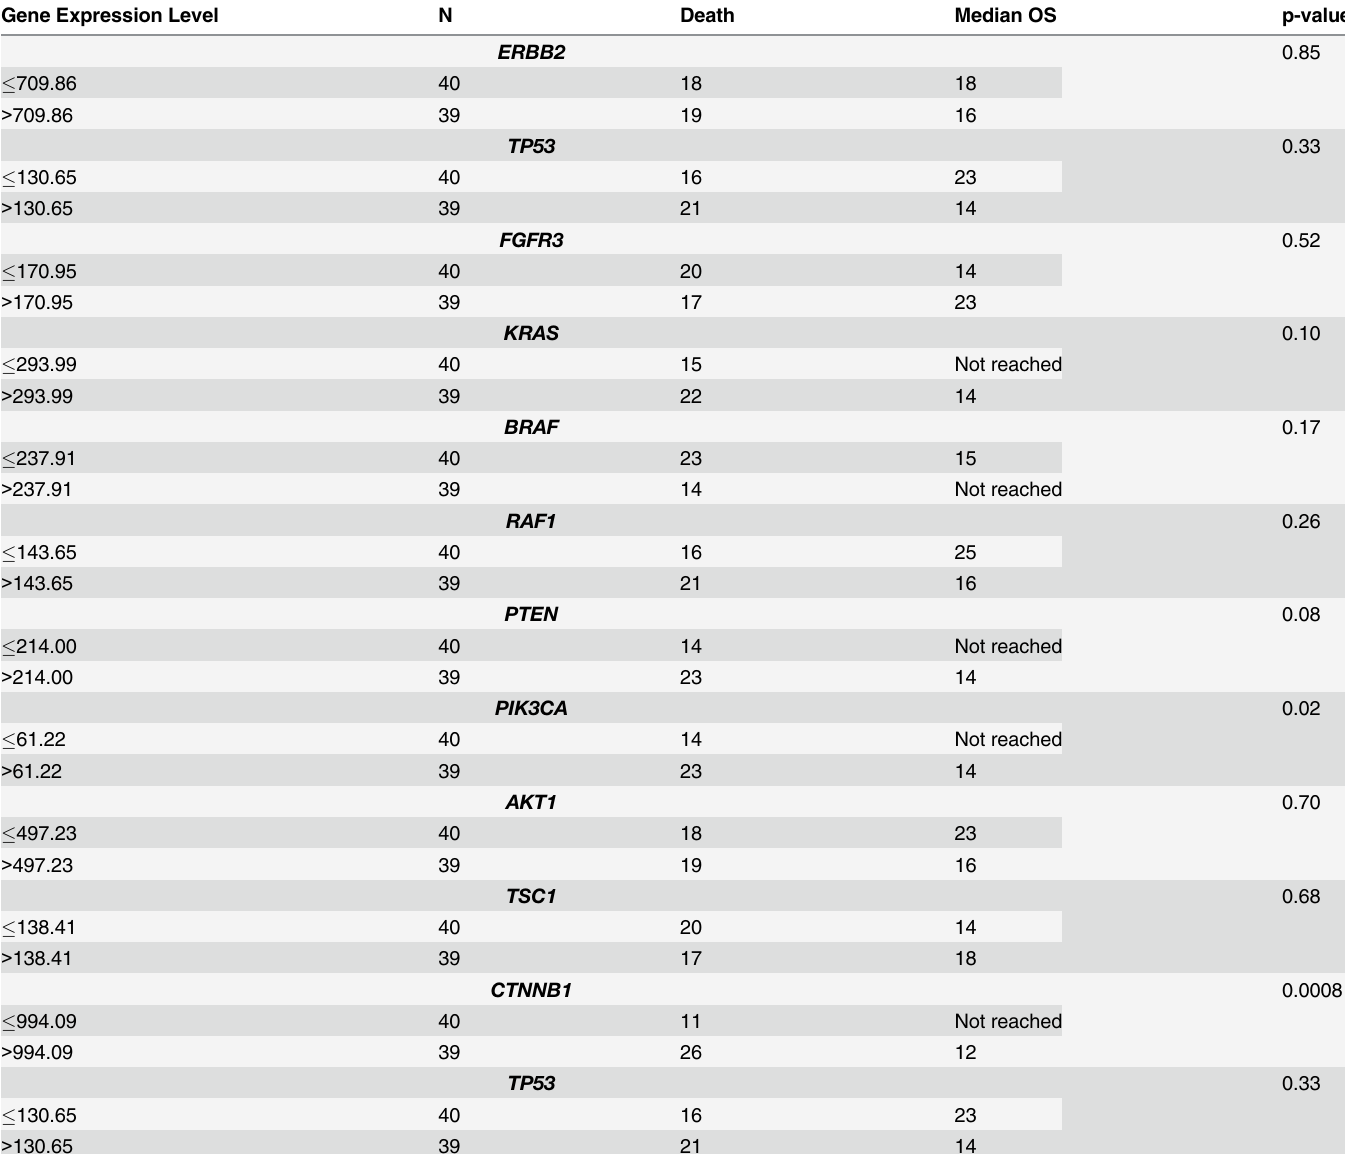
Table 5. Association between gene expression levels and OS.